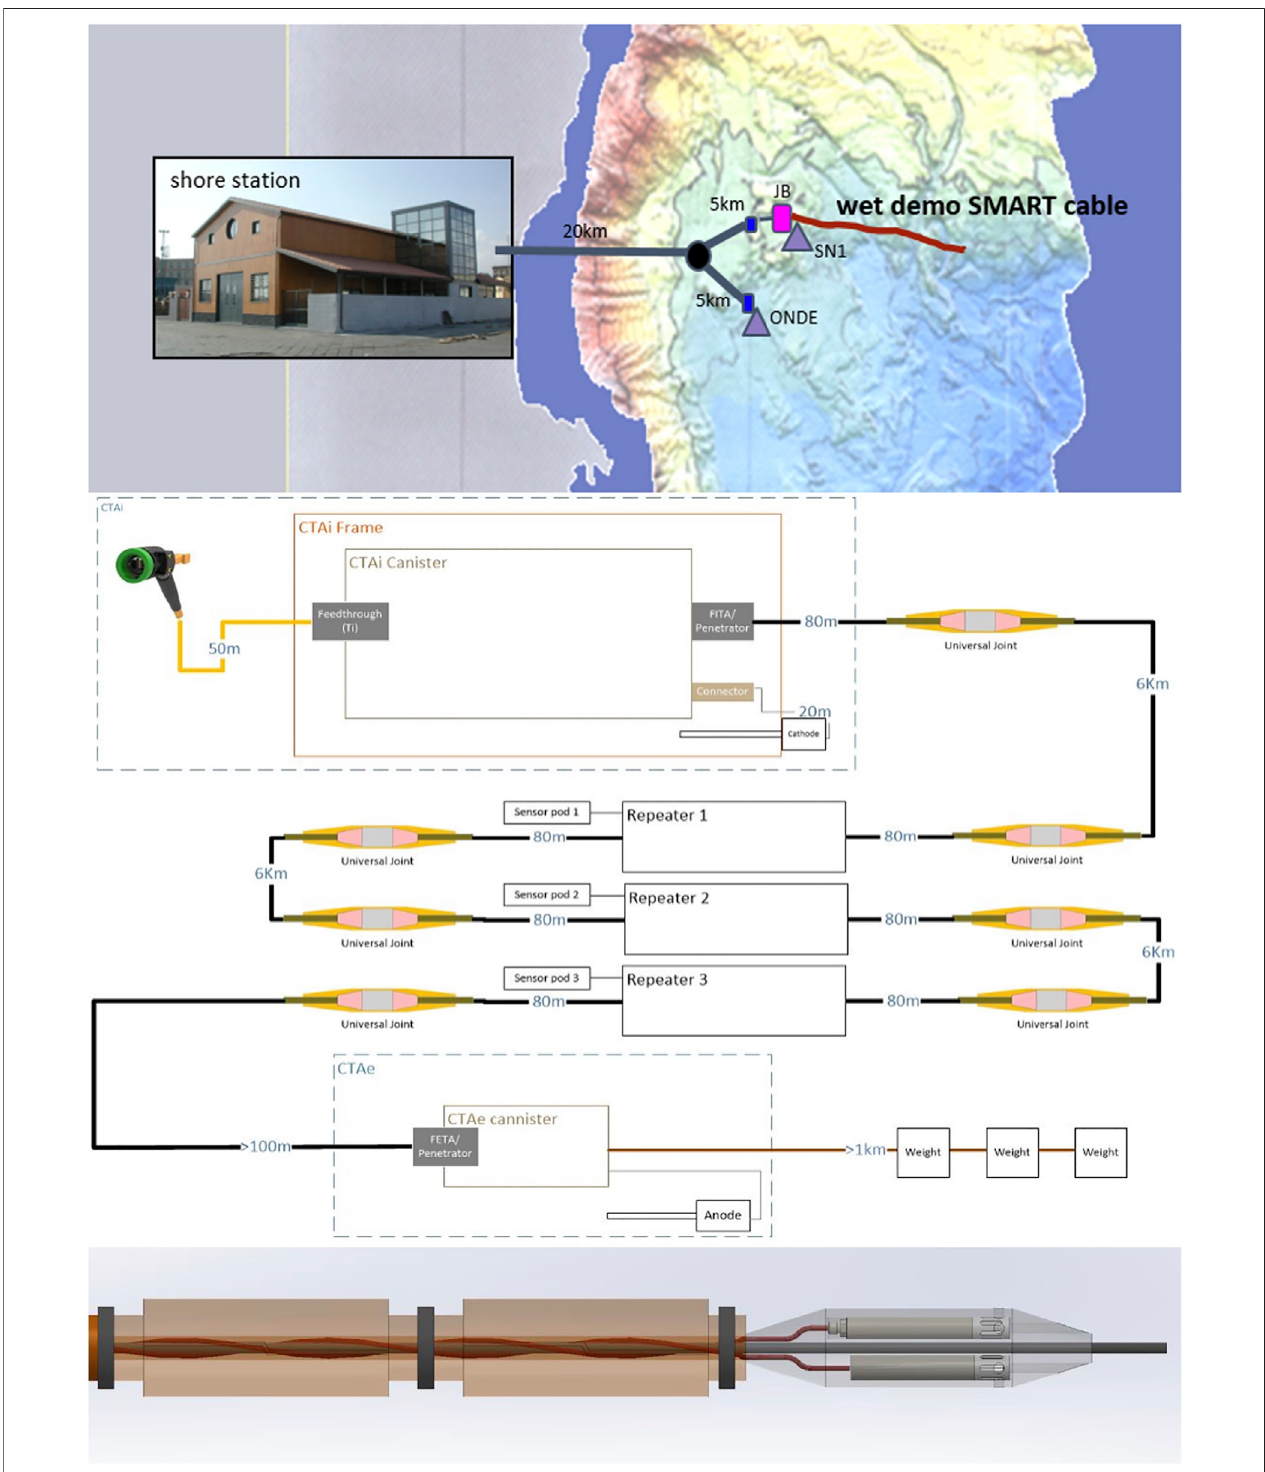
FIGURE 9 | (top) The EMSO Western Ionian Sea Facility where the InSEA wet demo SMART cable will be laid in 2022. (middle) The complete system diagram (bottom) Sensor pod containing pressure and temperature sensors.